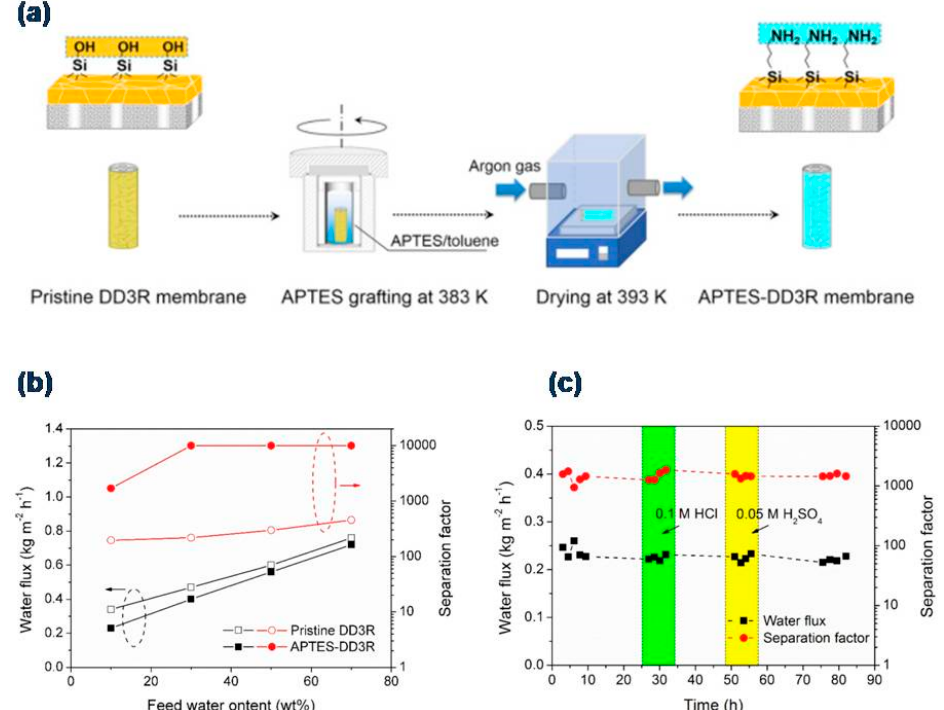
Figure 3. 3-aminopropyltriethoxysilane (APTES) grafted deca-dodecasil 3 rhombohedral (DD3R) membrane proposed by Zhang et al. for acetic acid dehydration (10 wt.% water, 75 °C, 200 Pa). Reproduced with permission from [50]; published by Elsevier, 2019. License number 5010730591021.